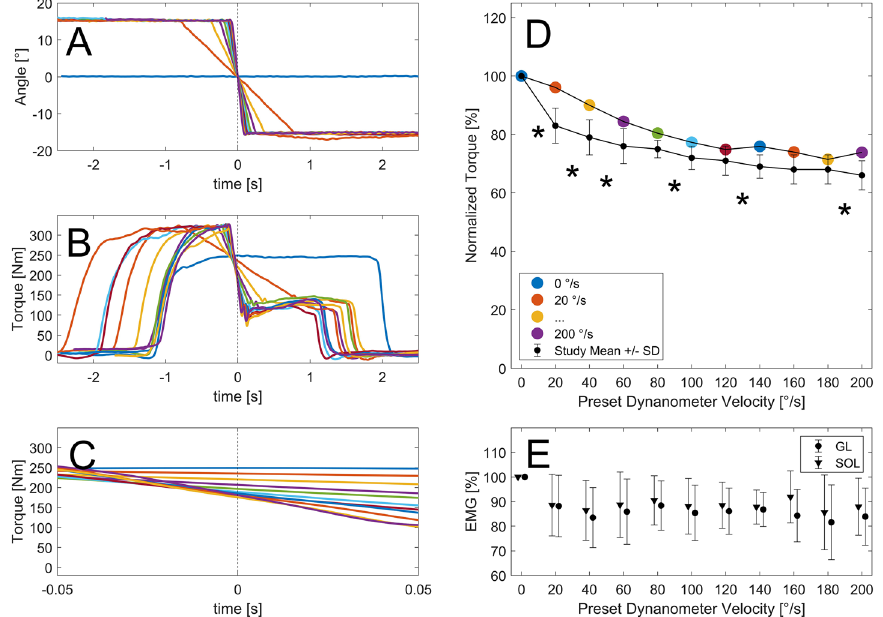
Figure 1. Experimental data for one exemplary participant. ( A ) Maximum voluntary shortening contractions were performed on a dynamometer moving from 15° dorsiflexion to 15° plantar flexion with angular velocities set between 20 and 200°/s with an additional fixed end reference contraction at 0°. ( B ) Dynamometer rotation was automatically initiated when ankle joint torque exceeded 95% of the individual maximum fixed-end plantar flexion torque at 15° dorsiflexion. ( C ) Torque measured when passing through 0° was used to create the individual and mean torque-velocity relationship ( D ). Muscle activity when passing through 0° was unaffected by contraction velocity ( E ). The legend provided in ( D ) serves as the legend for all colored subplots. *Statistically significant difference between successive contraction velocity conditions (p <